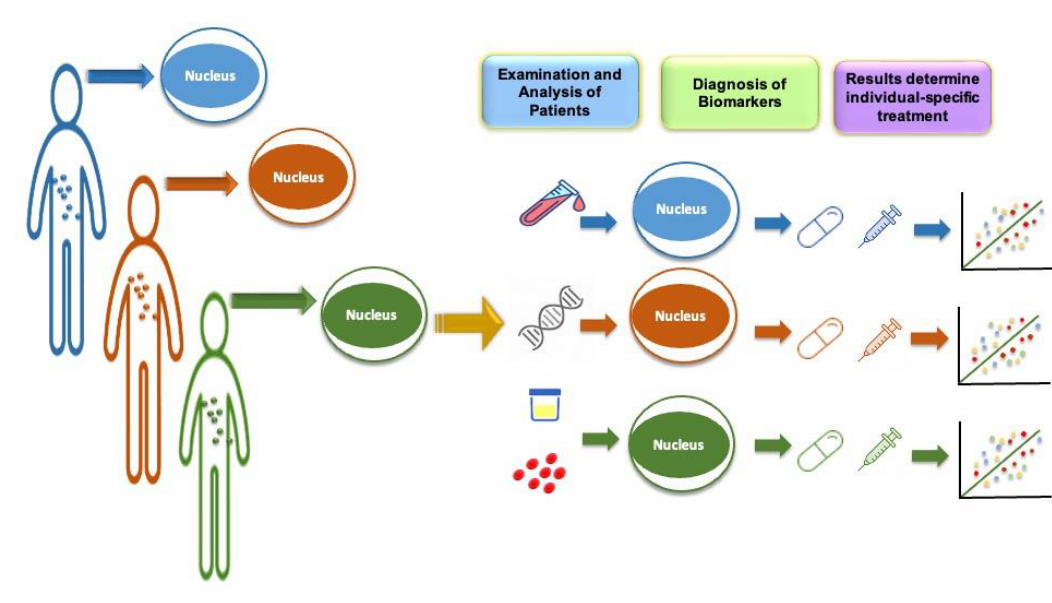
Figure 2. Precision medicine approach to prevention of disease. Precision medicine in Alzheimer’s disease involves the use of biomarkers, such as genetic and imaging markers, to accurately diagnose and classify patients based on the specific subtype of the disease they have. This allows for more tailored treatment approaches and the development of targeted therapies.